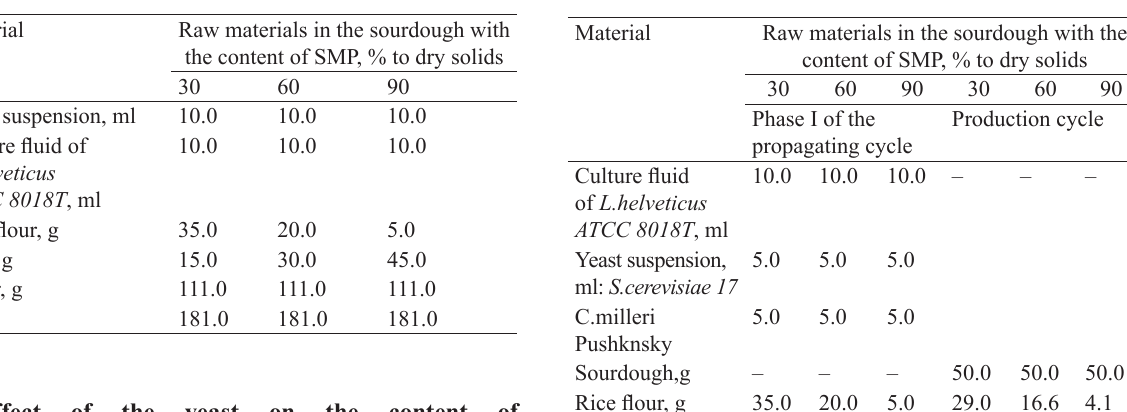
Table 3 Sourdough formulae with SMP in propagating and production cycles